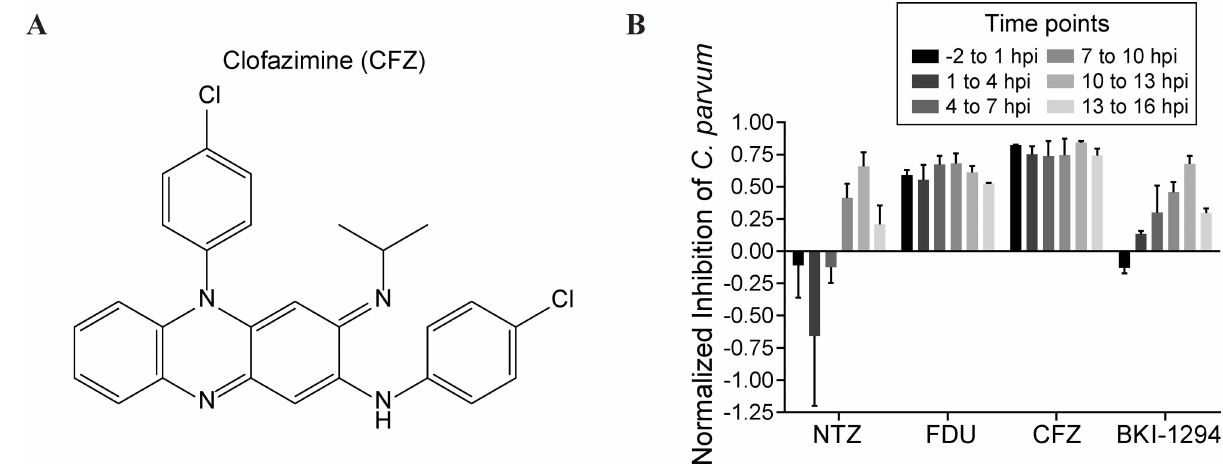
Fig 4. In vitro characterization of CFZ. (A) Chemicalstructure of CFZ. (B) CFZ inhibited C . parvum proliferation by (cid:21) 70% at every point of the asexuallife cycle. The first asexual life cycle after infection was evenly dividedinto six 3-h blocks, and labeledas hours post infection (hpi). Infected cells were treated by one of four compoundsat the EC 99 for 3 h followedby drug washout, and then allowedto continue growinguntil 48 hpi, when they were fixed, stained, imaged, and analyzedfor C . parvum proliferation. EC 99 values: NTZ = 8 μ M; FDU = 100 nM; CFZ = 30 nM; BKI-1294 = 2 μ M. Data shown are the mean ± SEM of two